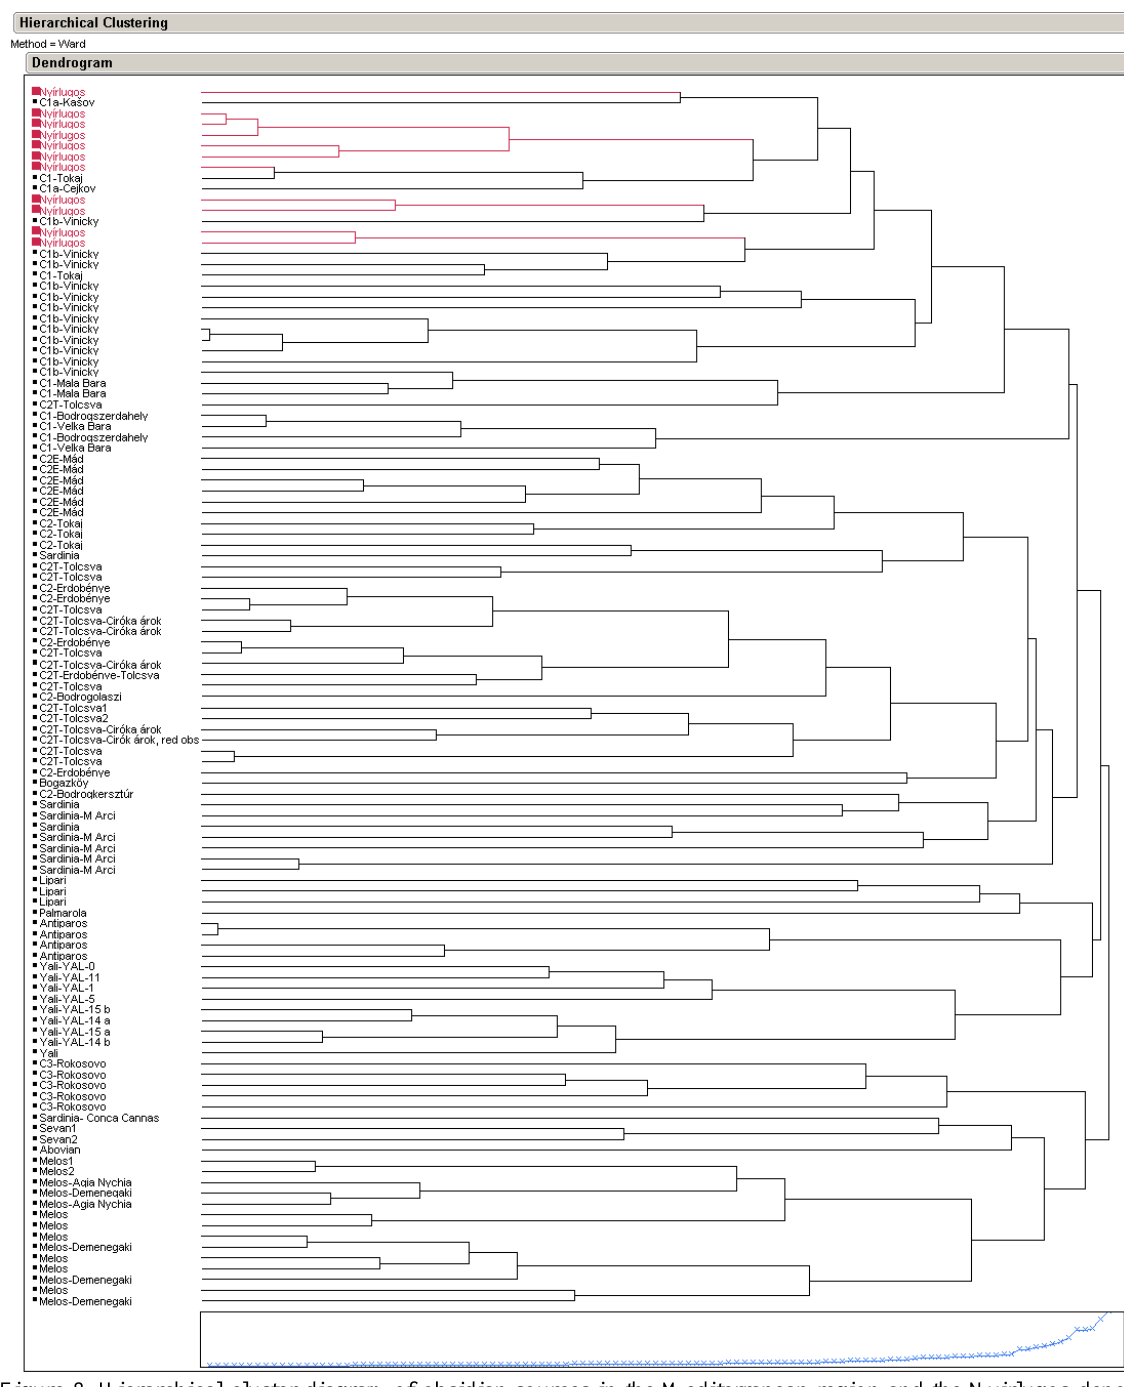
Figure 8. Hierarchical cluster diagram of obsidian sources in the Mediterranean region and the Nyirlugos depot